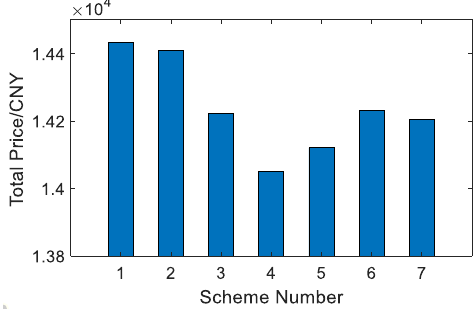
Figure 11. Comparison of total price.